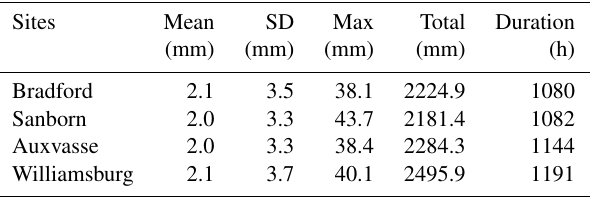
Table 1. Characteristics of hourly rain gauge data at Bradford, Sanborn, Auxvasse, and Williamsburg between April 2016 and June 2018. Mean: mean values, SD: standard deviation, Max: max- imum values, Total: sums of rain amounts, and Duration: sum of rainfall time.